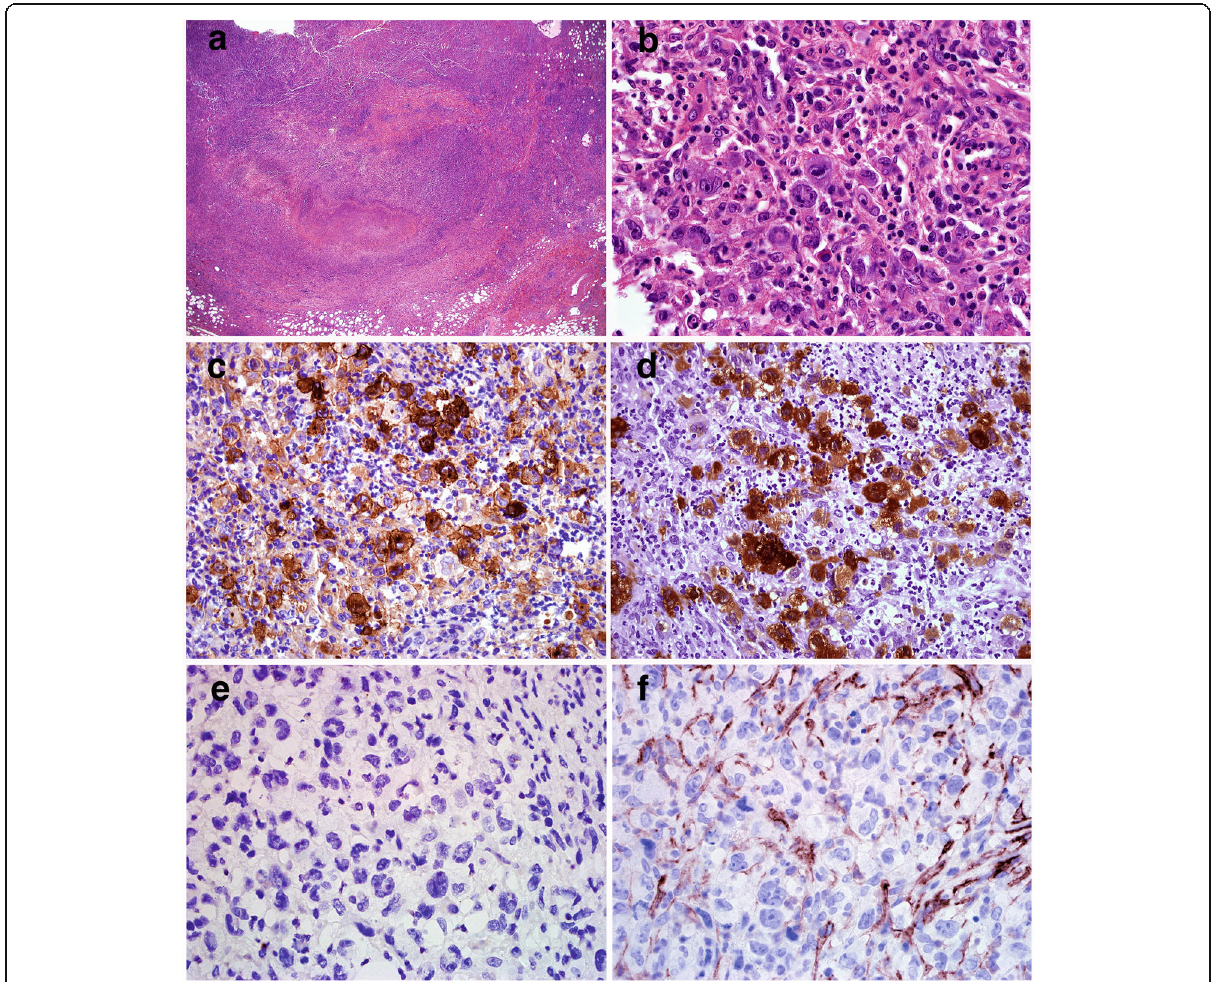
Fig. 4 Langerhans cell sarcoma. The inguinal lymph node biopsy shows a complete effacement of the lymph node architecture by an abnormal polymorphous infiltrate of histiocytes, small lymphocytes, neutrophils, eosinophils and rare plasma cells, with scattered and focal sheets of atypical large cells with convoluted nuclei ( a H&E, 100X, b H&E, 600X). The large cells are CD1a + and S100+ ( c CD1a IHC, 600X; d S100 IHC, 600X). The morphology and phenotype is consistent with a diagnosis of Langerhans cell sarcoma. The large cells were CD20-, CD19- (not shown), PAX5- (not shown) and CD10- ( e CD20 IHC, 600X; f CD10 IHC,